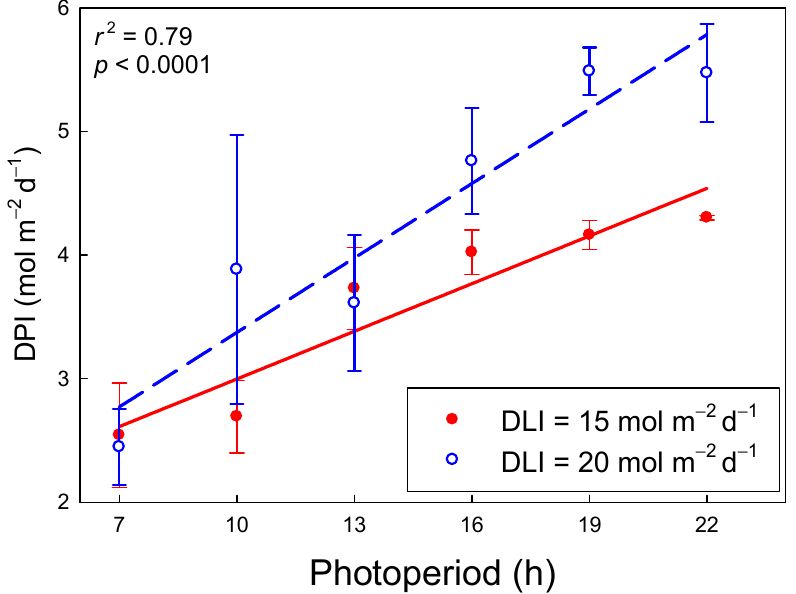
Figure 4. The daily photochemical integral (DPI) of lettuce ( Lactuca sativa ‘Green Towers’) as a function of photoperiod and daily light integral (DLI) [DPI = 1.508 + (0.00953 × photoperiod × DLI)]. Plants measured under longer photoperiods, or under the same photoperiod but at a lower DLI, received a lower photosynthetic photon flux density (PPFD) (Table 1). There was a significant interaction ( p < 0.001) between DLI and photoperiod as indicated by the different slopes of the regression lines.